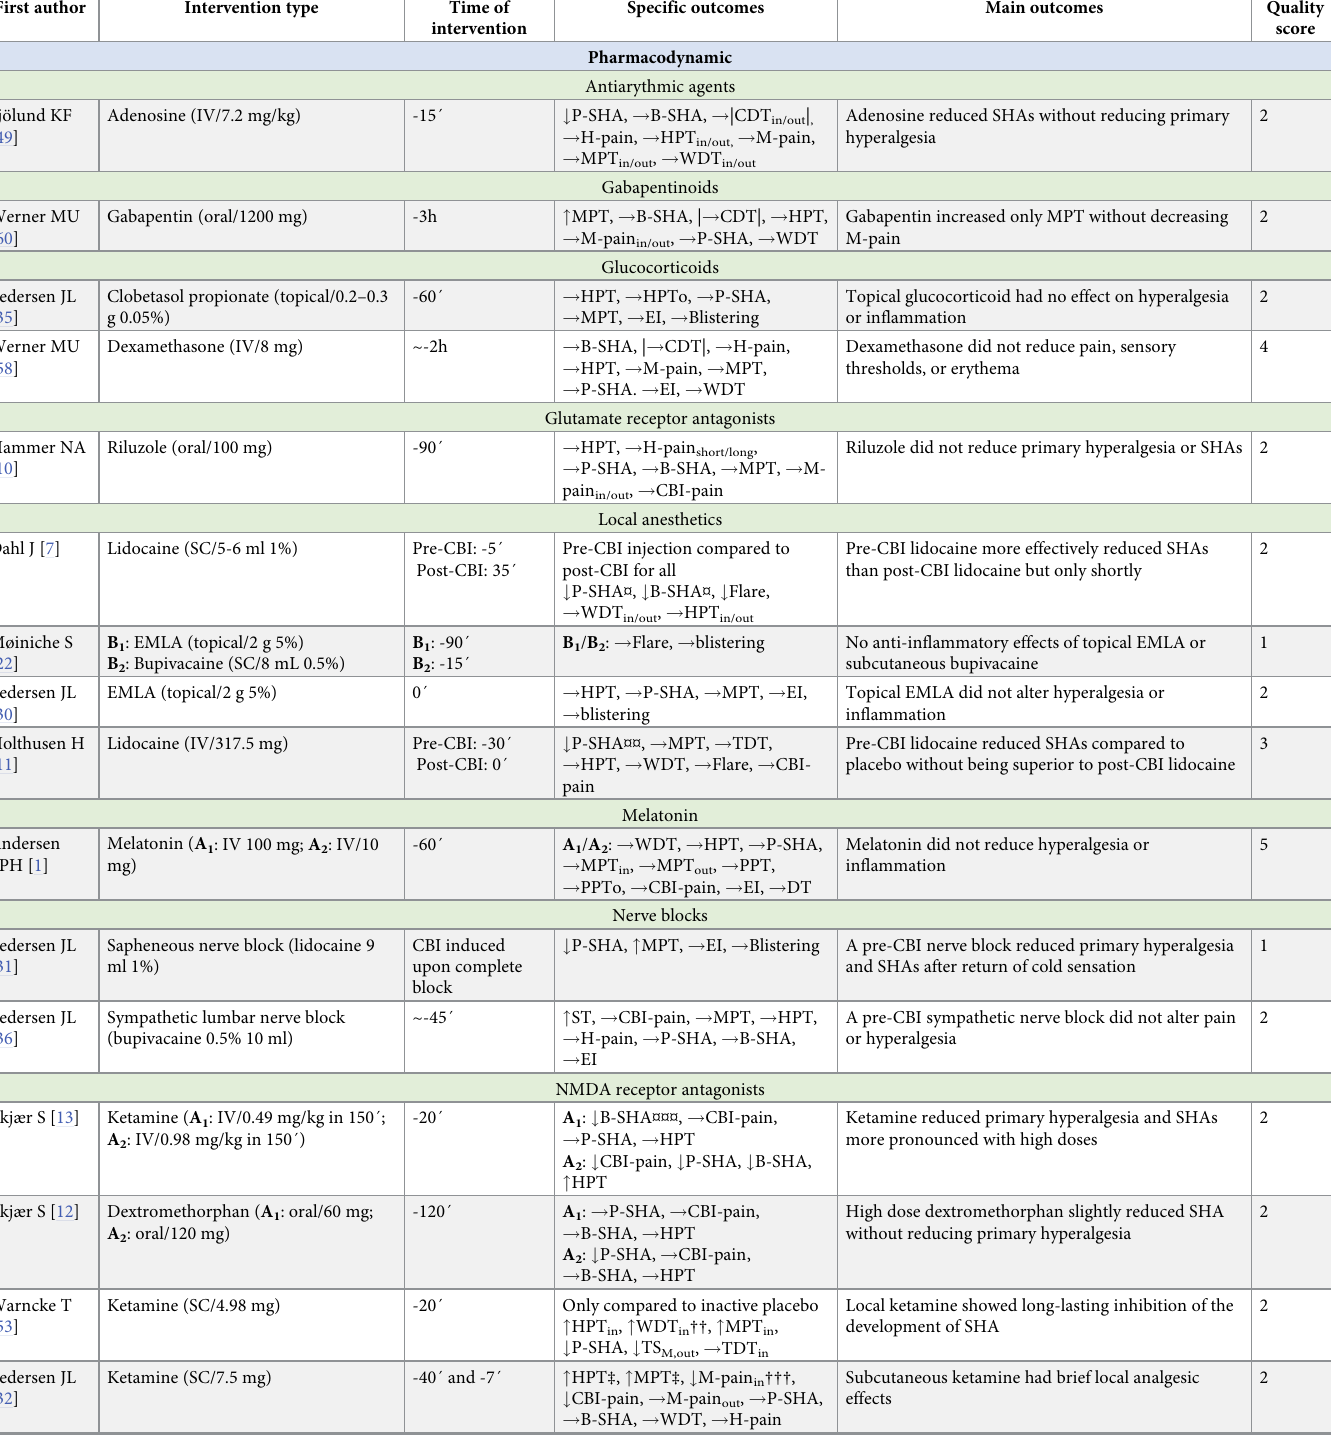
Table 3. Intervention study